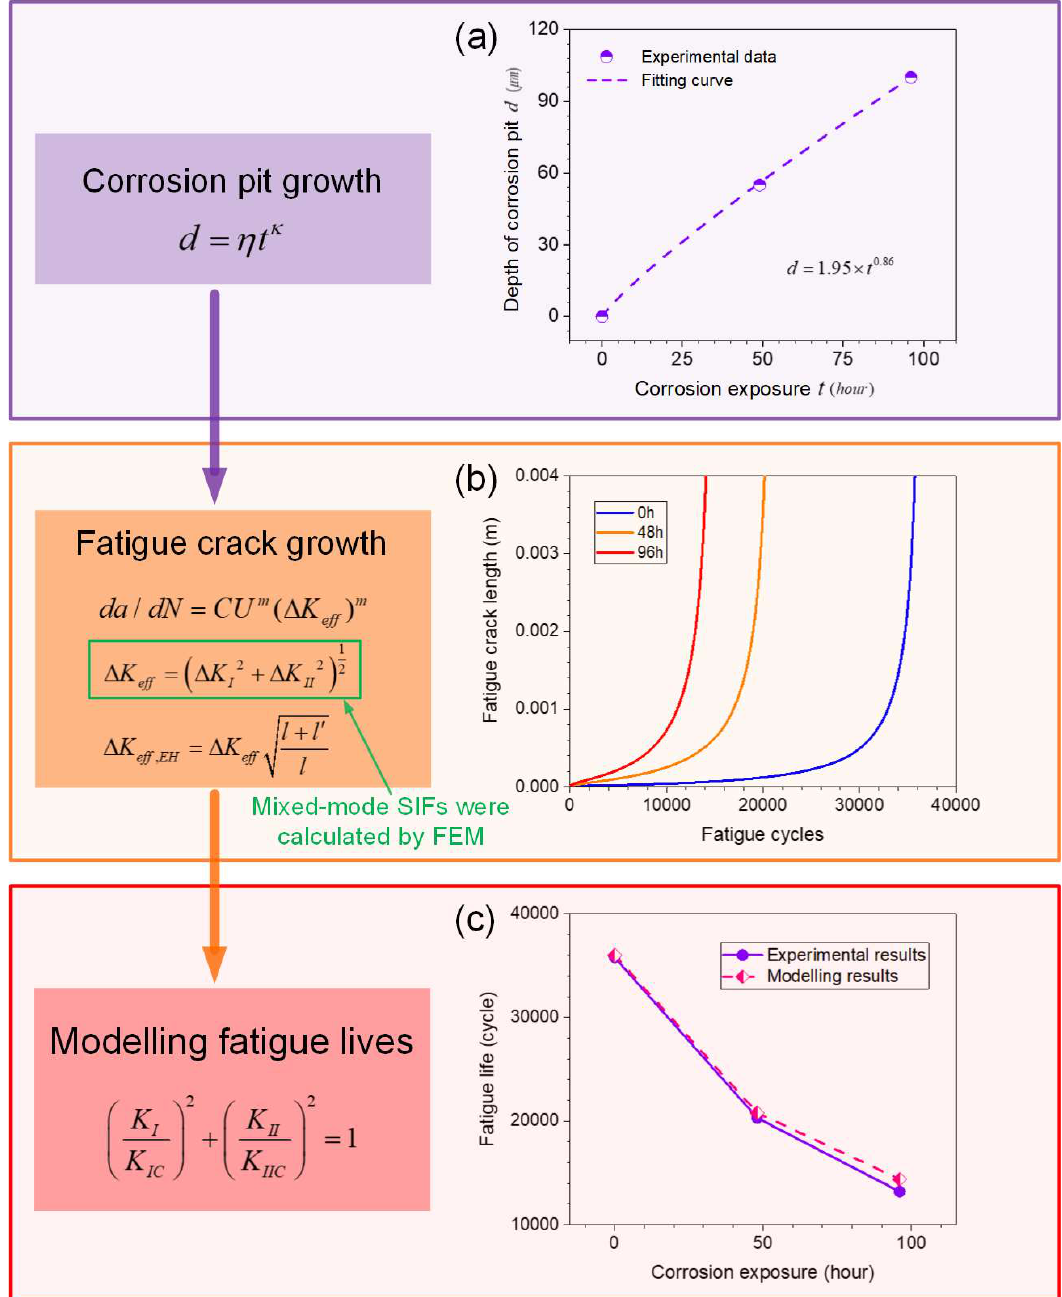
Figure 16. ( a ) Pit depth growth versus corrosion time, ( b ) fatigue crack growth for specimens with different corrosion times, ( c ) predicted and measured fatigue lives of specimens with different corrosion times.